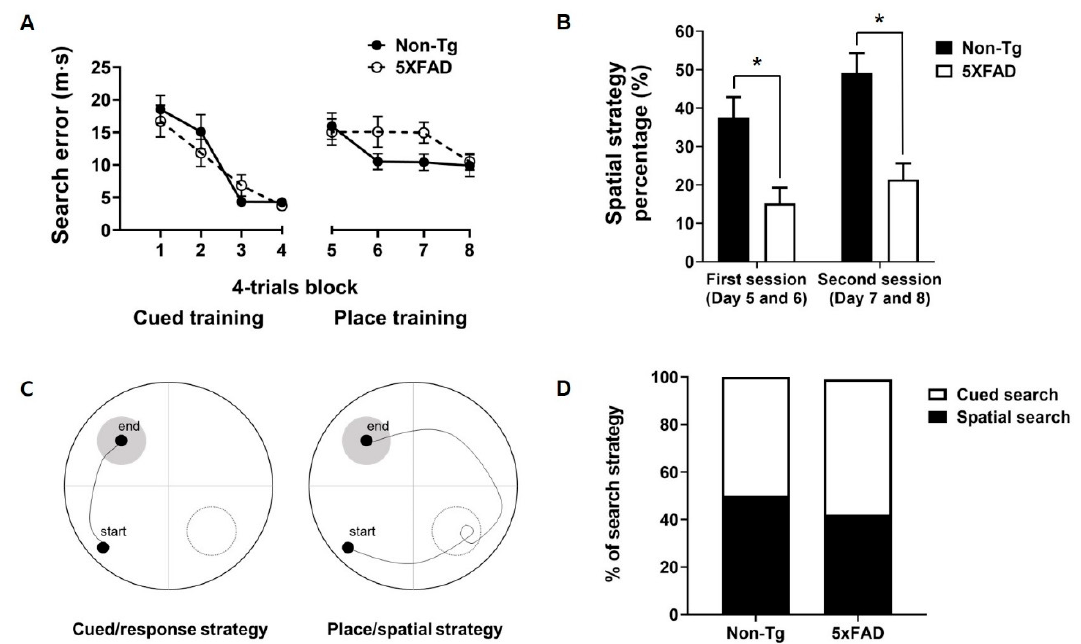
Figure 1. Performance of 4-month-old 5XFAD and non-Tg control mice in the switching task from cued/response training to place/spatial training. ( A ) No significant difference between non-Tg and 5XFAD mice in search error was observed in the cued/response training and place/spatial training. ( B ) 5XFAD mice adopted the spatial search strategy less in the place/spatial training than did control mice. ( C ) Representative figure of the swim path in the competition test. ( D ) No difference between 5XFAD and control mice in the preference for a search strategy in the competition test was found. Non-Tg, n = 14; 5XFAD, n = 14. * p < 0.05.